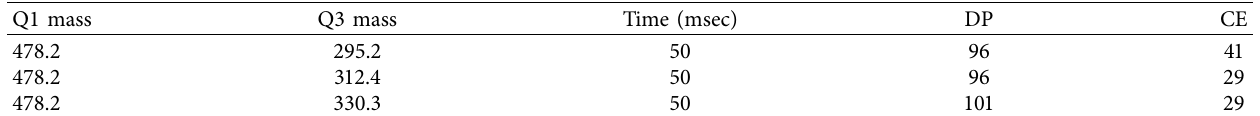
Table 3: MRM transitions monitored for 13 C